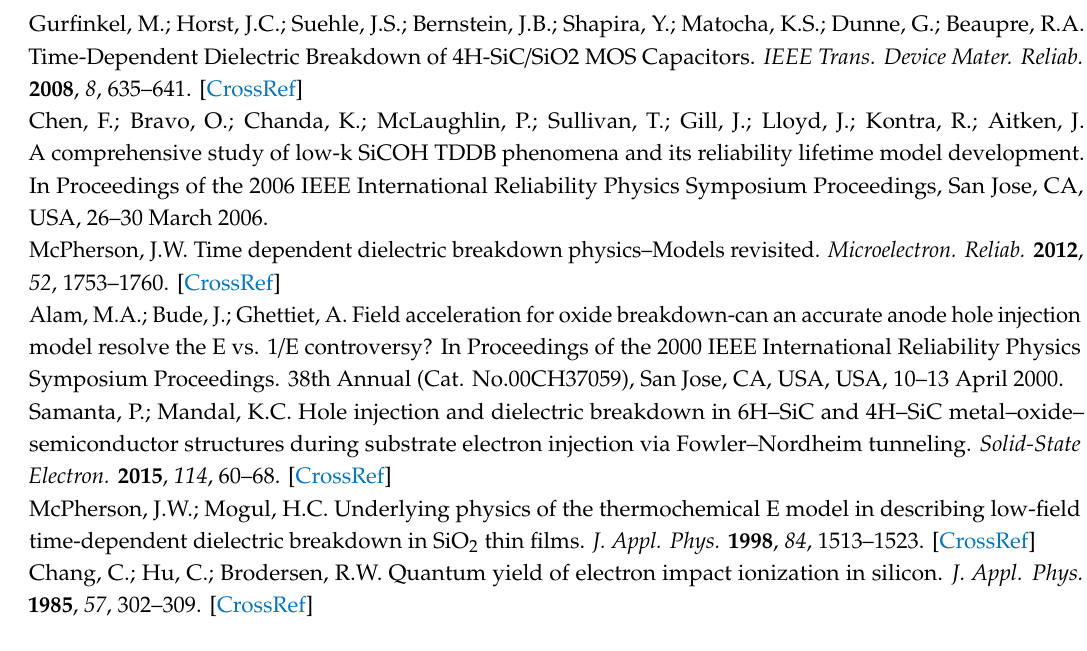
Figure 6. Lifetime versus temperature plot obtained from the proposed TDDB hybrid model and actual measured data.